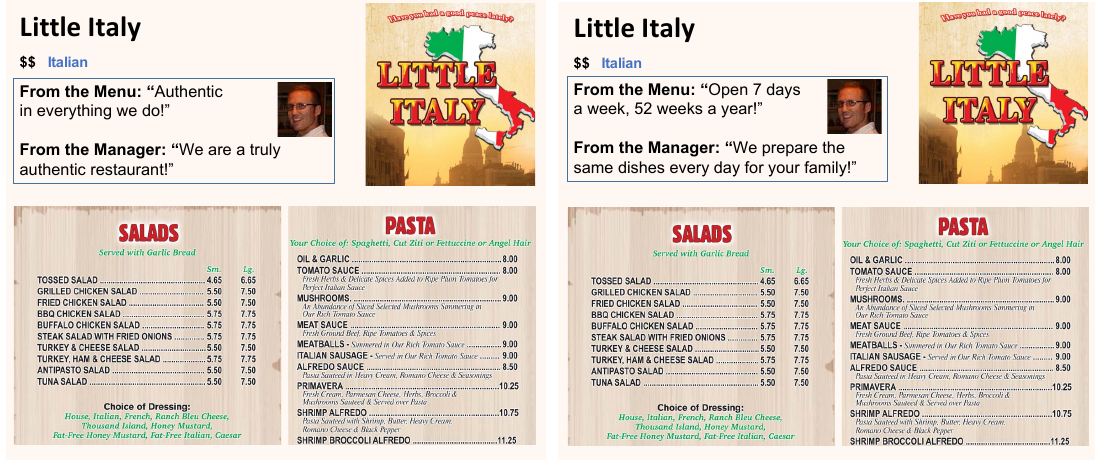
Figure 3: Restaurant profiles from experiment (study